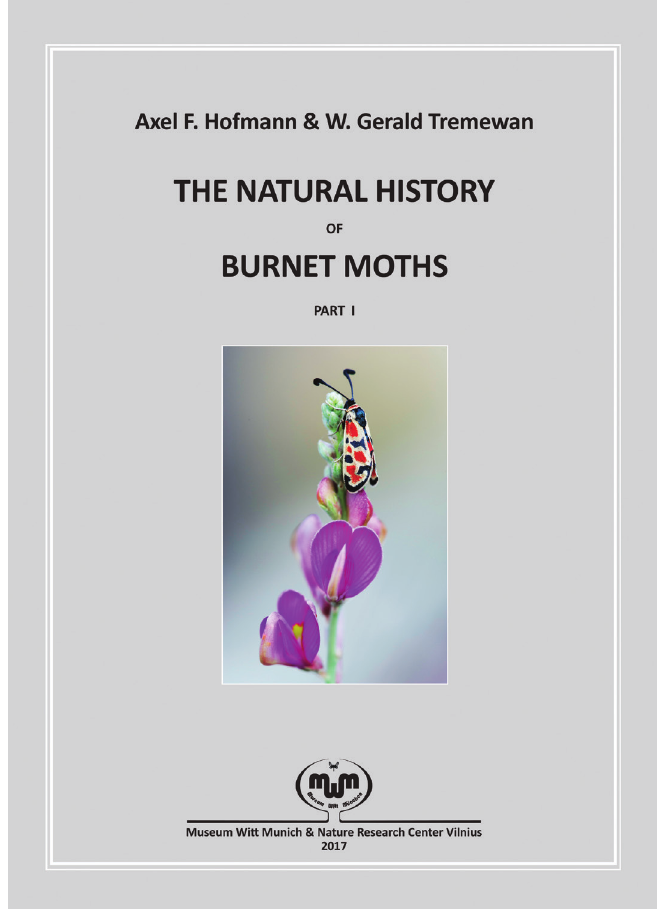
Figure 1. Cover of the